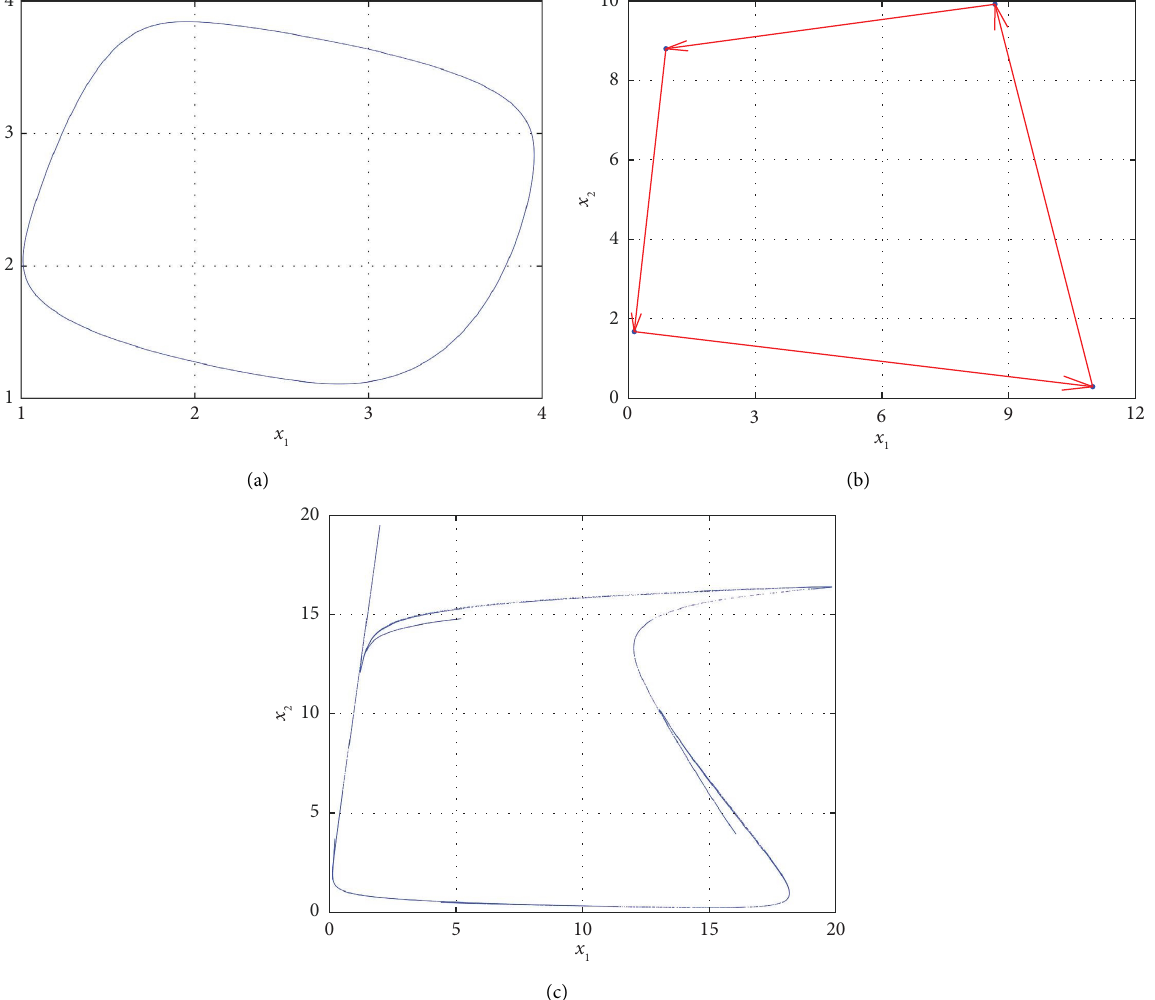
Figure 7: Dynamics generated by map (2). Parameter values ( μ